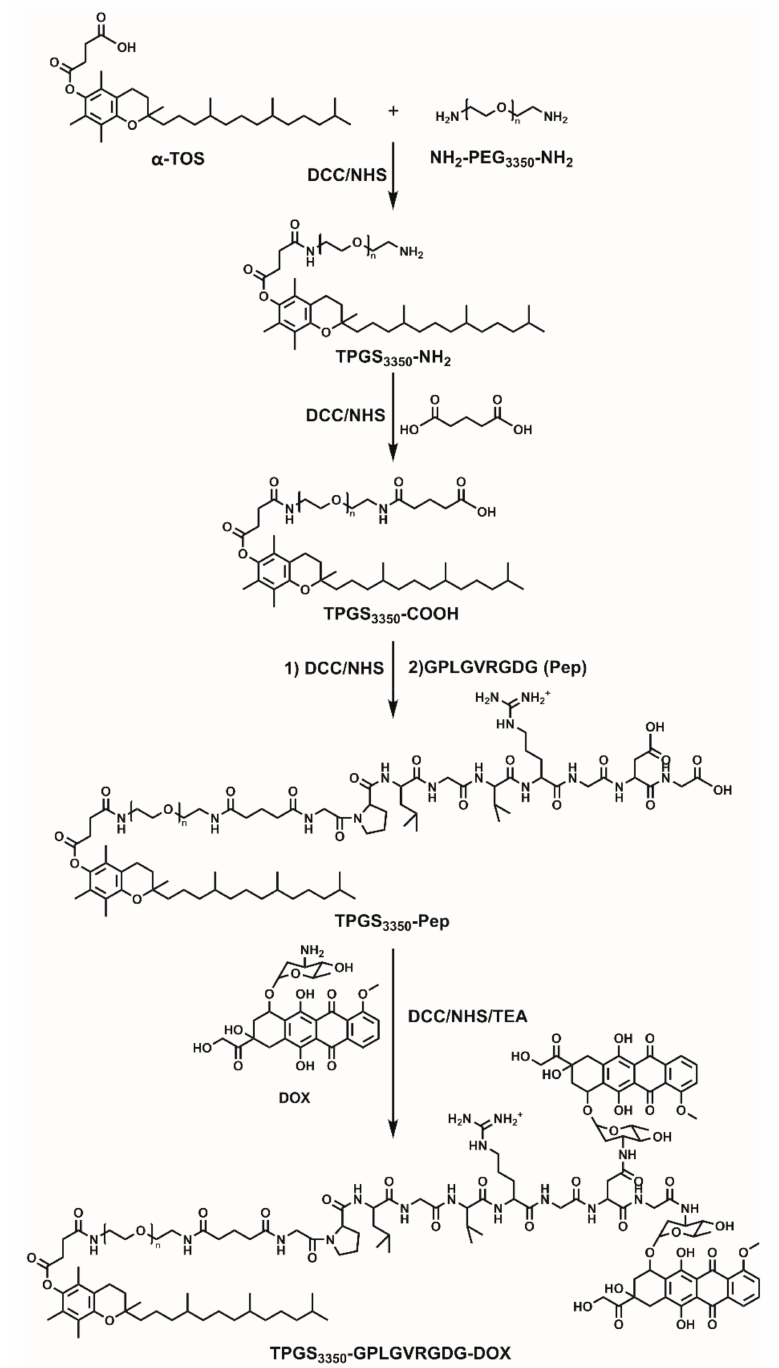
Figure 1. Synthetic route of TPGS 3350